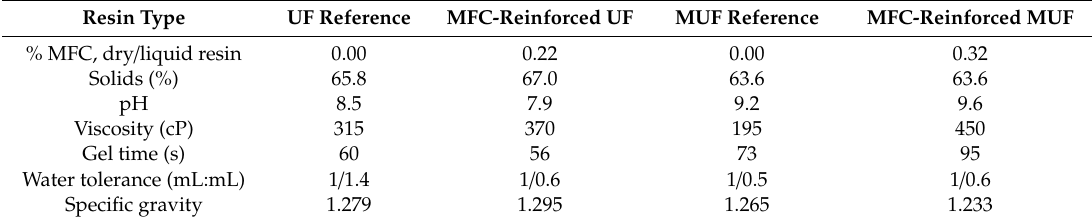
Table 1. Urea-Formaldehyde (UF) and Melamine-Urea-Formaldehyde (MUF) resins analysis results, Particleboard.